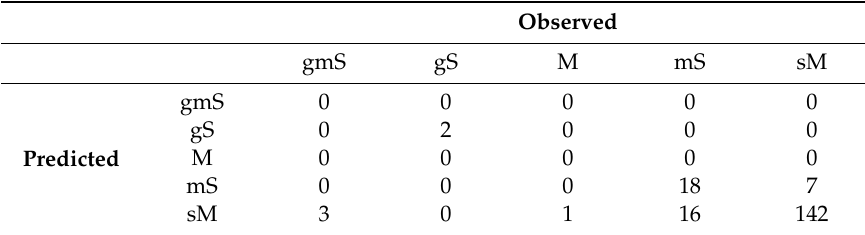
Table A5. Categorical simplified Folk LOO CV error matrix.